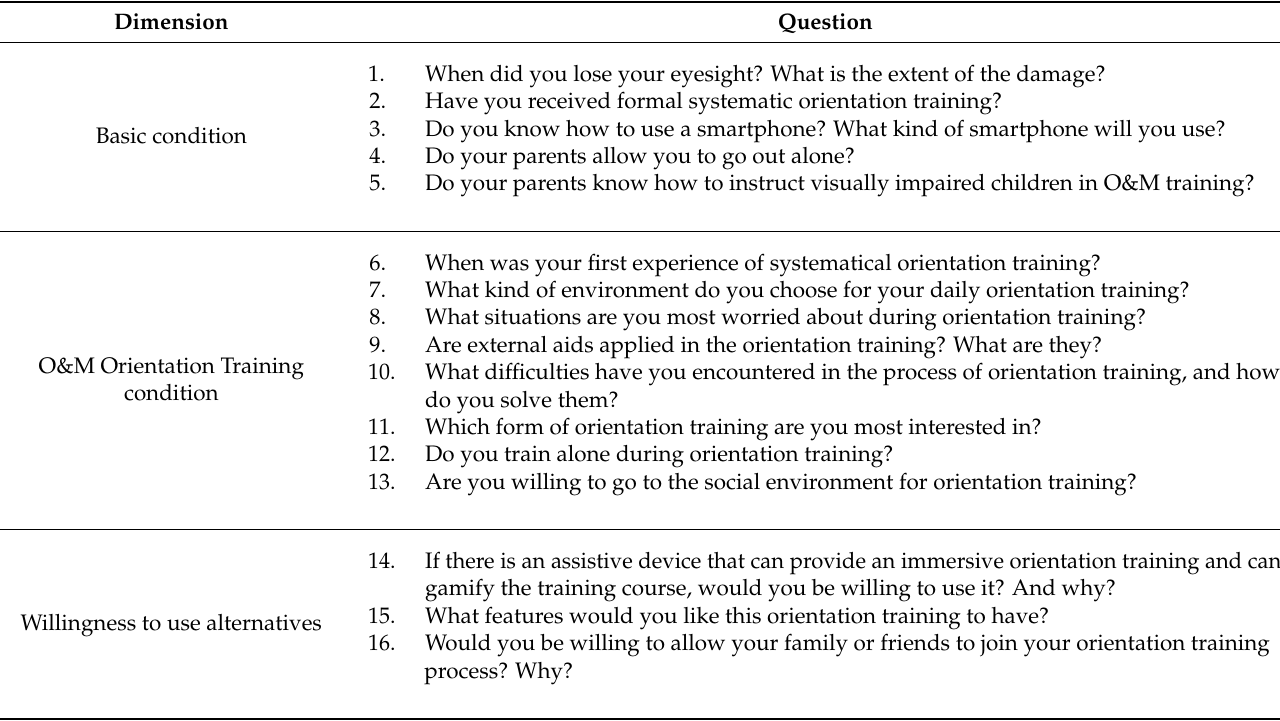
Table 1. The dimensions and questions of user